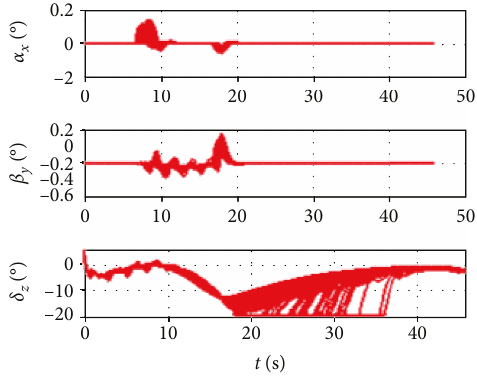
Figure 23: Curves representing the missile ’ s position projected onto the launch coordinate frame.